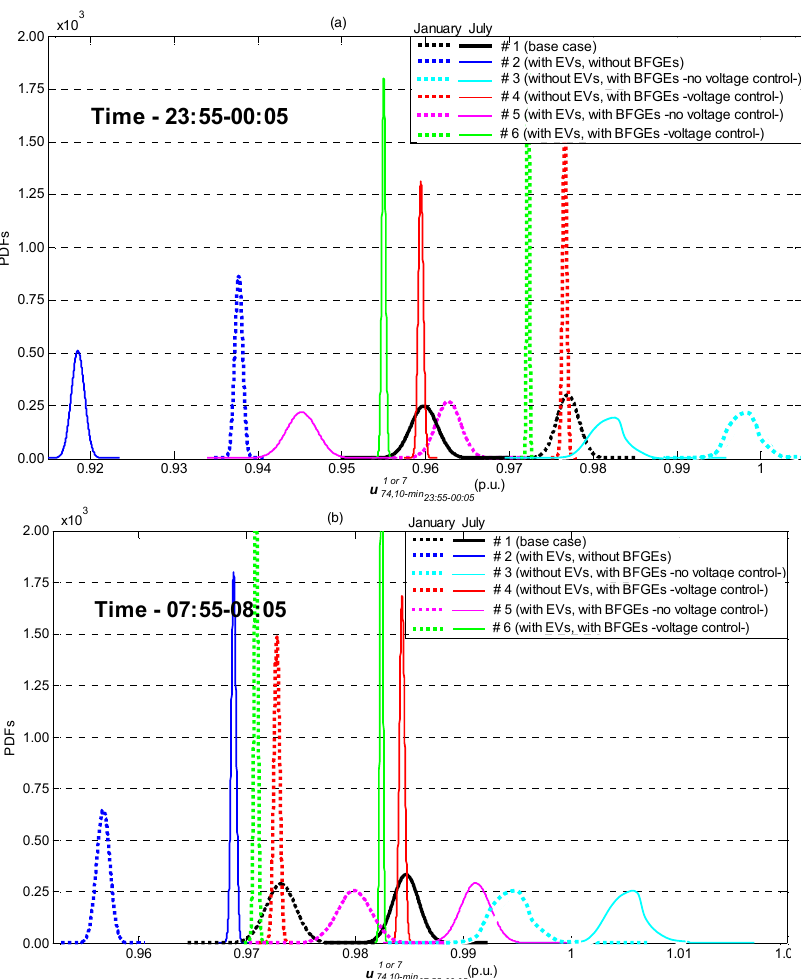
Figure 8. PDFs of the 10-min voltage magnitude at node 74 in different scenarios. ( a ) around 00:00 h; ( b ) around 08:00 h.